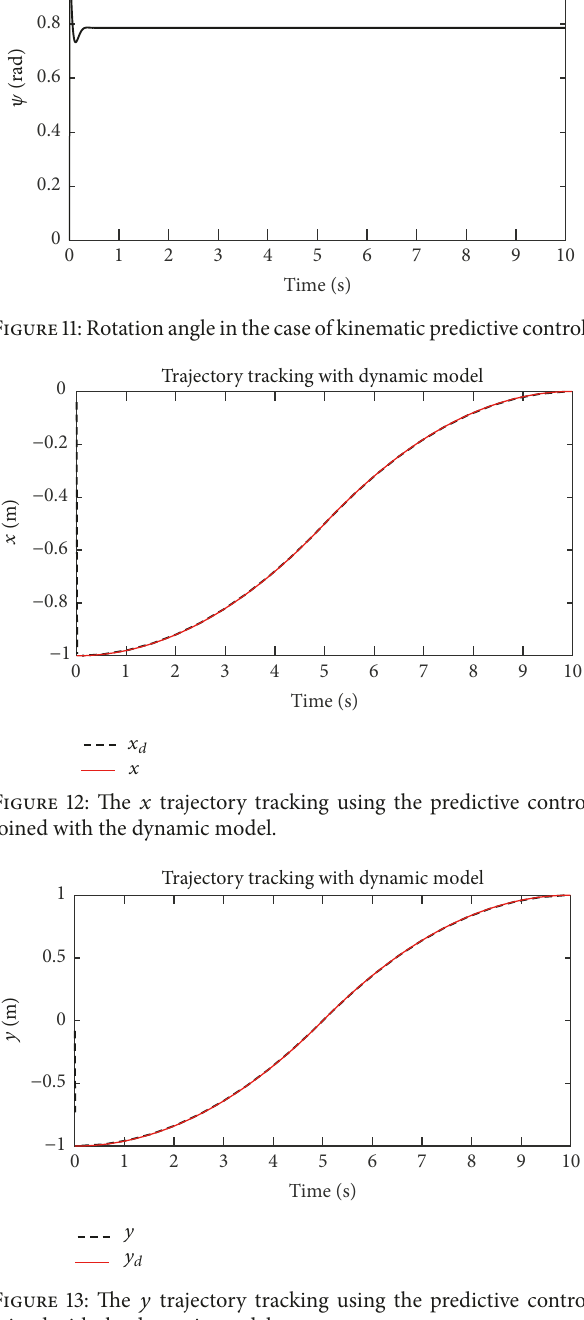
Figure 10: Linear velocity in the kinematic predictive control.